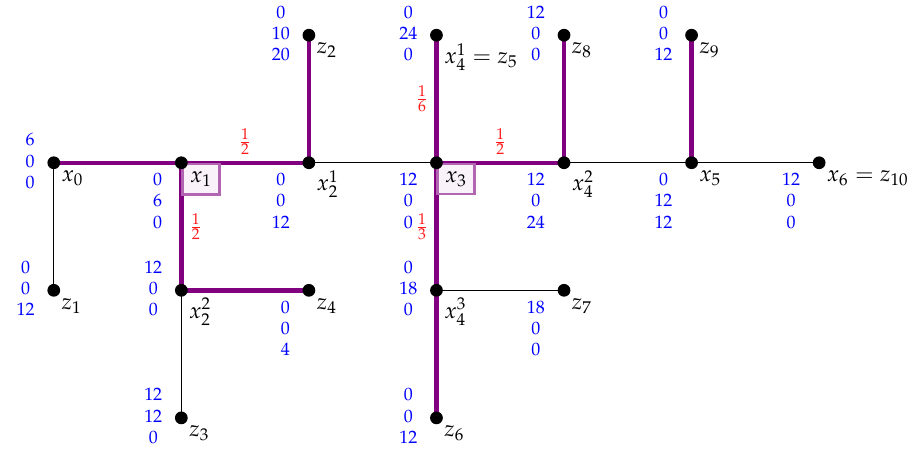
Figure 1. 3-person extensive-form game: A-Subgame Perfect Equilibria (SPE) algorithm